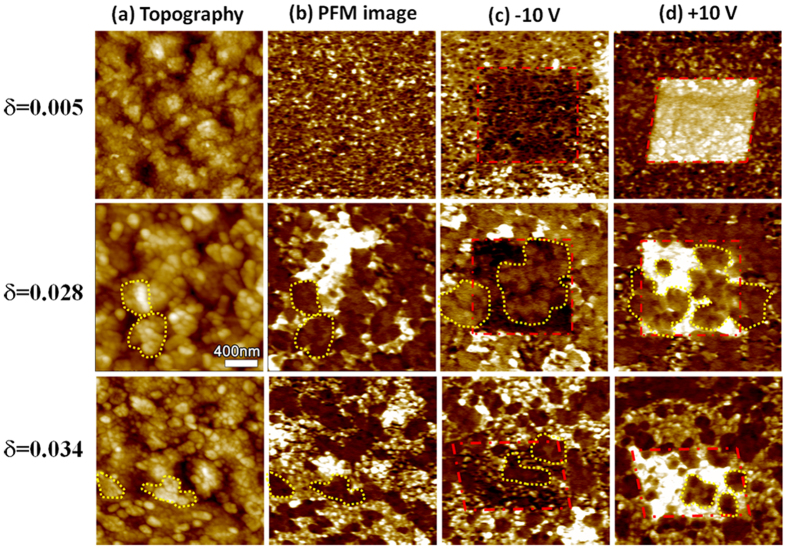
(a) Topography images and (b) OP-PFM amplitude images of Bi1-δFe0.95Mn0.05O3 films with the inner frame area polarized under (c) -10 V and (d) + 10 V, respectively. The size of the scanning area for all the images is 2 μm × 2 μm with the inner frame area 1 μm × 1 μm.